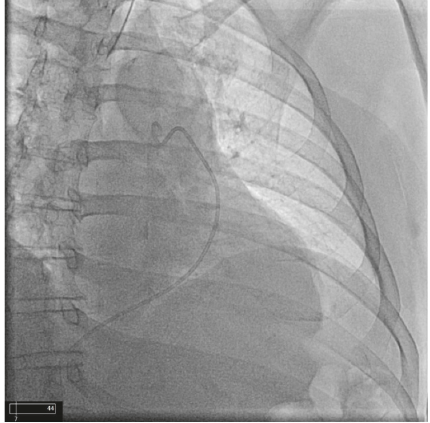
Figure 1: Before injection with catheter in pulmonary